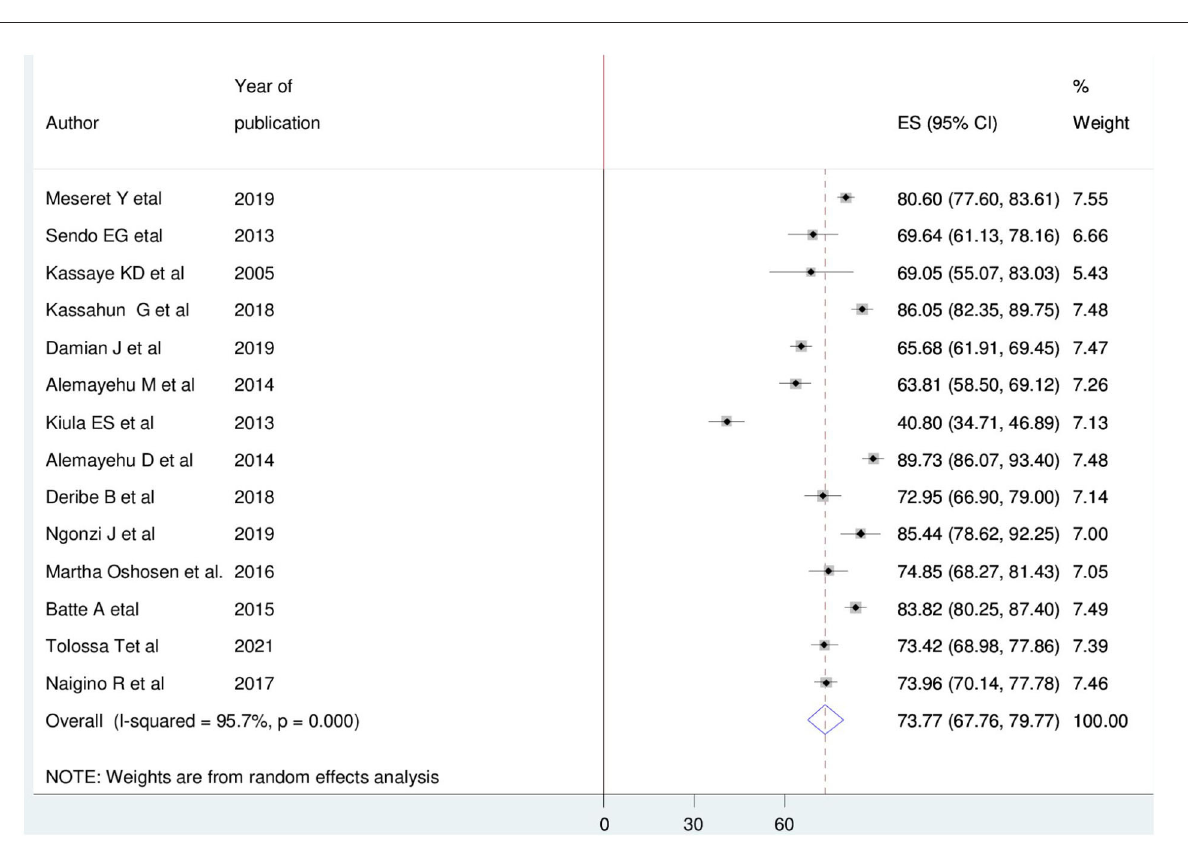
FIGURE2 Forest plot of the pooled magnitude of HIV positive sero-status disclosure among women in East Africa,